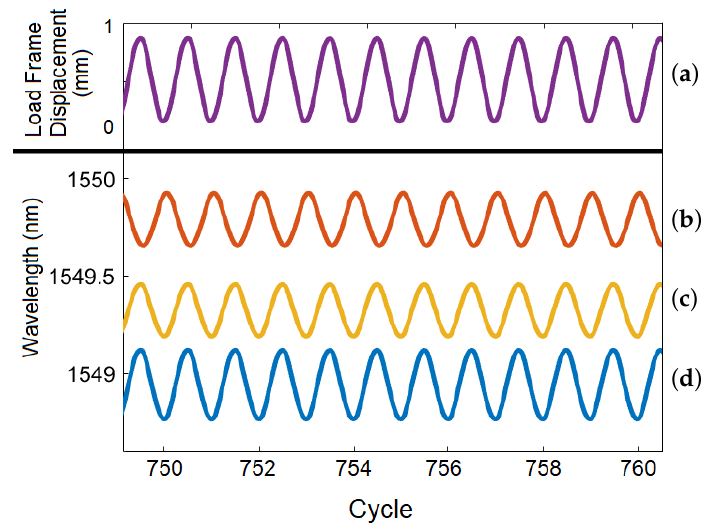
Figure 13. ( a ) Load frame displacement and FBG signals from sensors embedded ( b ) 9 mm, ( c ) 6 mm, and ( d ) 3 mm from the notch over the entire prognostic analysis test.